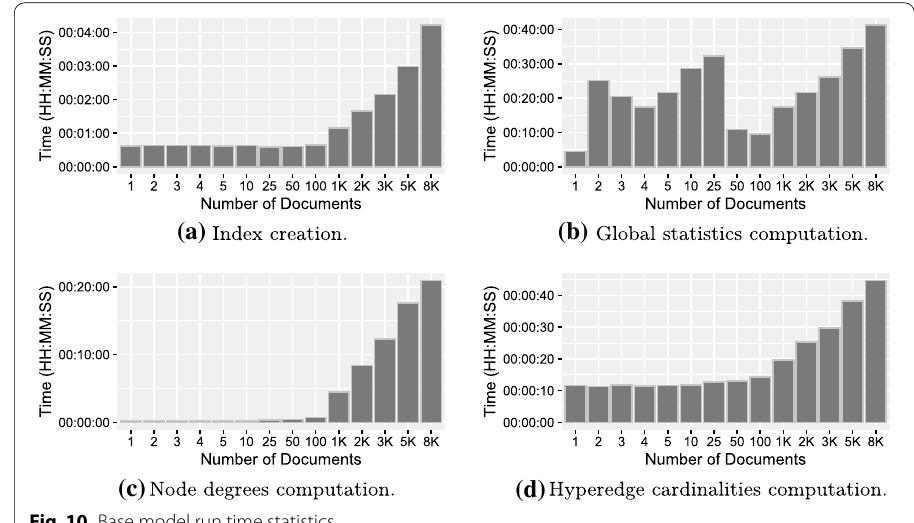
Fig. 10 Base model run time